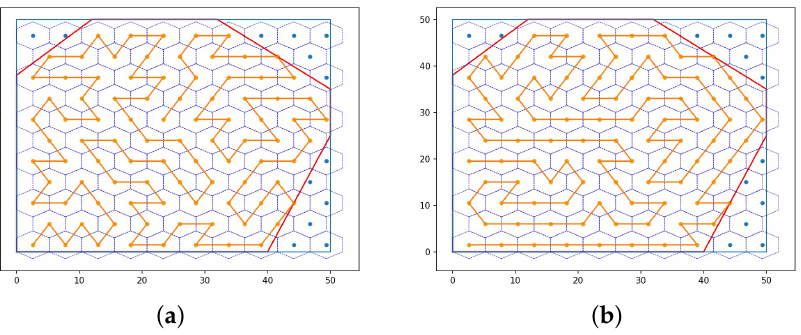
Figure 4. Path planning results. ( a ) Result of GA with the sum of angles 114.14; ( b ) result of DF-GA with the sum of angles 92.15, whose sum of turn angles is smaller than the GA result, with more straight